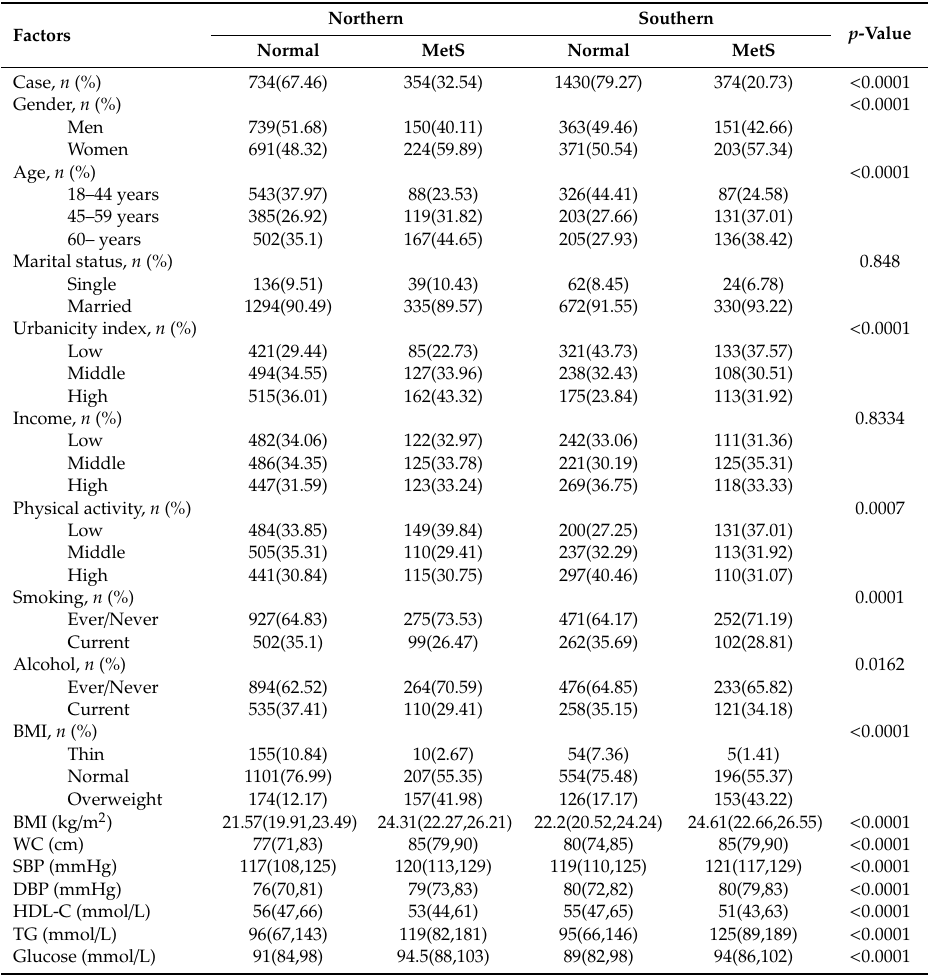
Table 2. Baseline characteristics of normal and developed into MetS in 2015 by